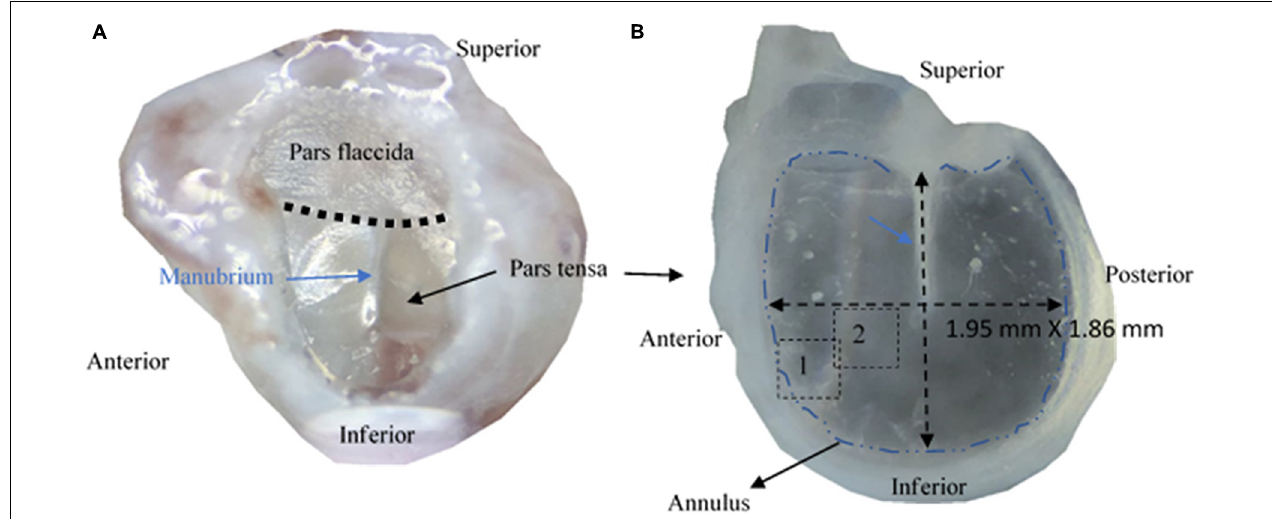
FIGURE 1 | Photographs of tympanic membranes of mice. (A) A tympanic membrane of a mouse is typically made of pars flaccida and pars tensa. (B) The pars tensa attached with the anulus was extracted for studying the 3D microstructure using multiphoton